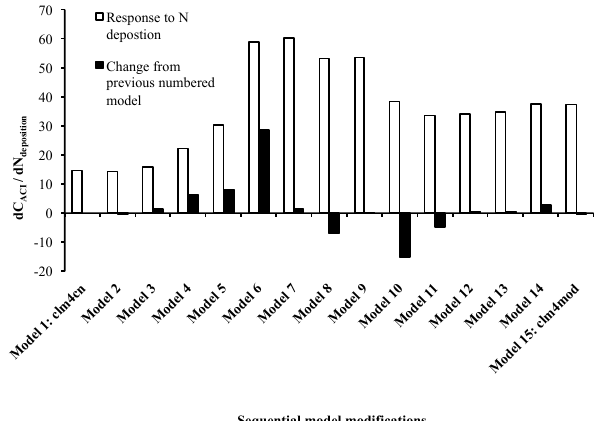
Fig. 4. The sensitivity of the nitrogen deposition response to key changes in model structure for a single site (Harvard Forest). The figure shows the nitrogen deposition response, expressed as an an- nual aboveground carbon increment (dC ACI /dN deposition ) for the clm4cn model (Model 1), clm4mod (Model 15), and intermediary models (Model 2–14). Each model builds on the modifications in the previous models, and the difference in dC ACI /dN deposition be- tween a model and the previous model is shown in black. See Ta- ble 3 for a description of the mechanisms isolated in each